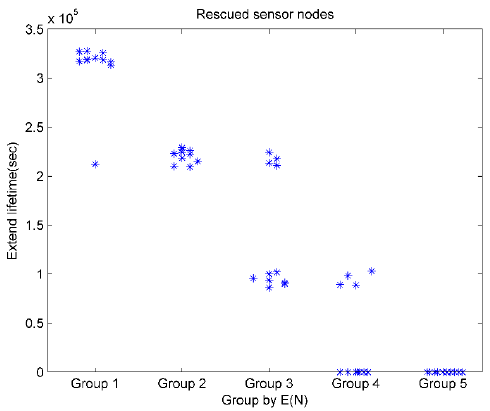
Figure 13. Distribution of the rescued sensor nodes.